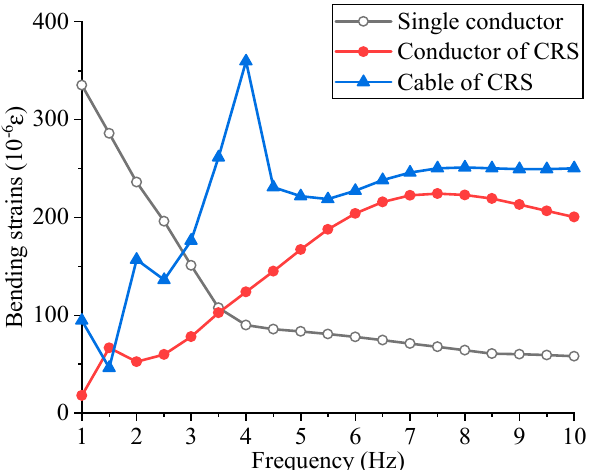
Figure 24. Bending strains of conductor and cable in 89 mm from clamp exit (wind load applied on conductor and cable).